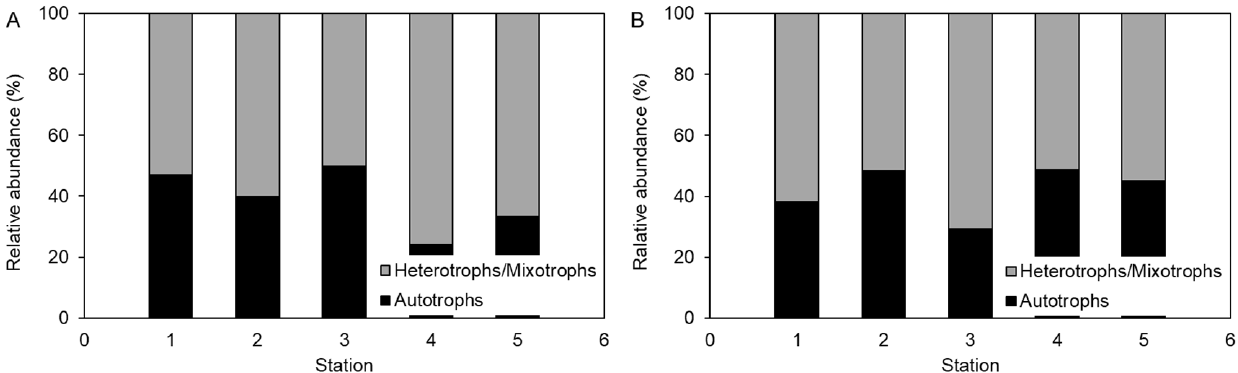
Figure 6. Relative abundance of autotrophic and heterotrophic/mixotrophic cysts. ( A ) Relative abundance in May, ( B ) Relative abundance in September.